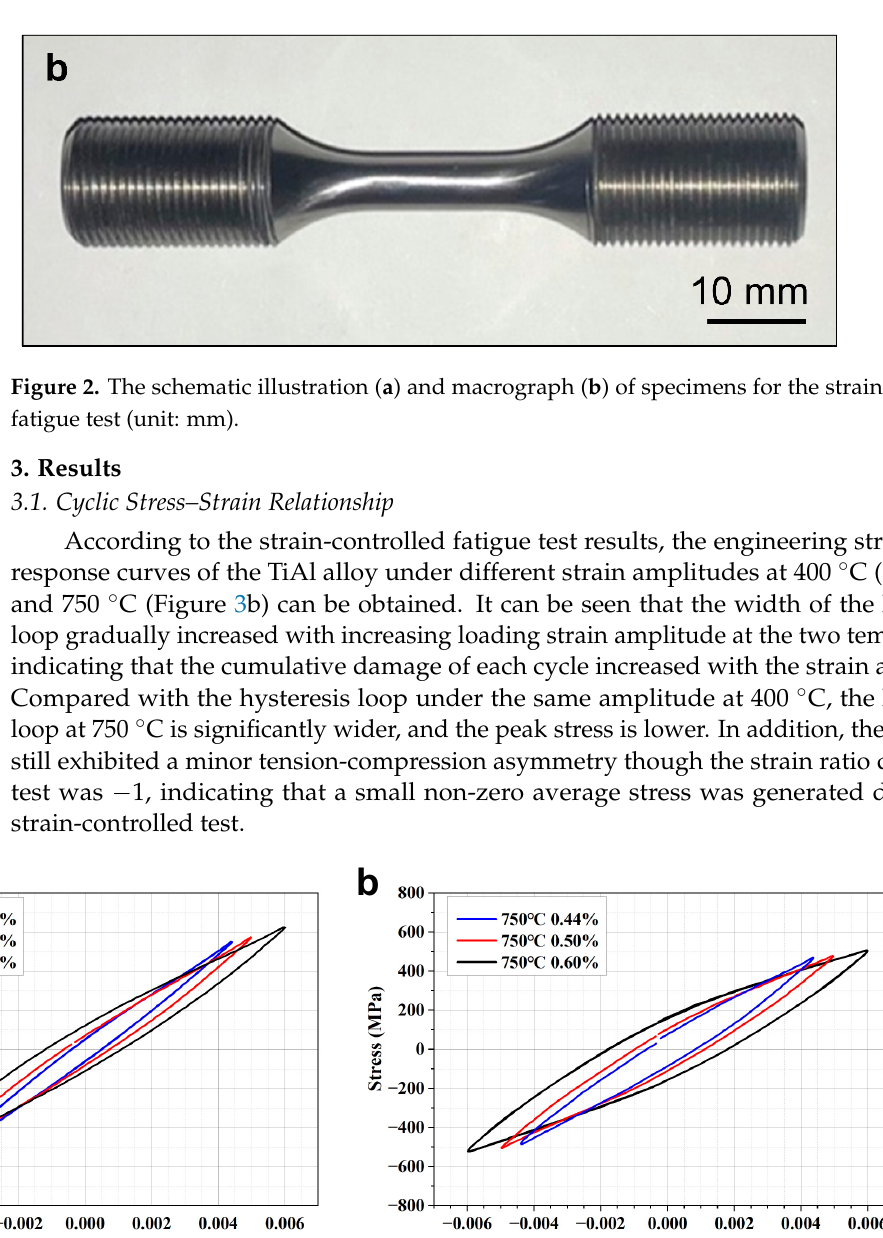
Figure 4. Cyclic peak stress of the TiAl alloy at different temperatures.